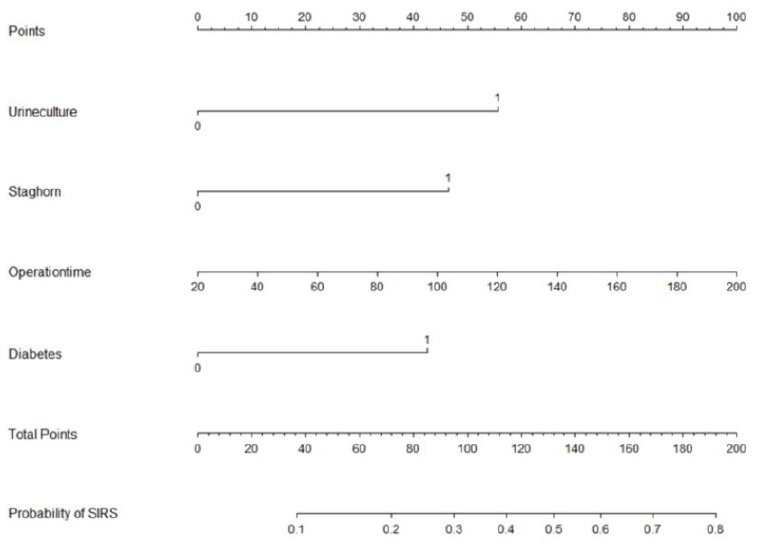
Figure 3. Nomogram with positive urine culture, staghorn calculi, operation time, and diabetes predicts the probability of post-PCNL SIRS.